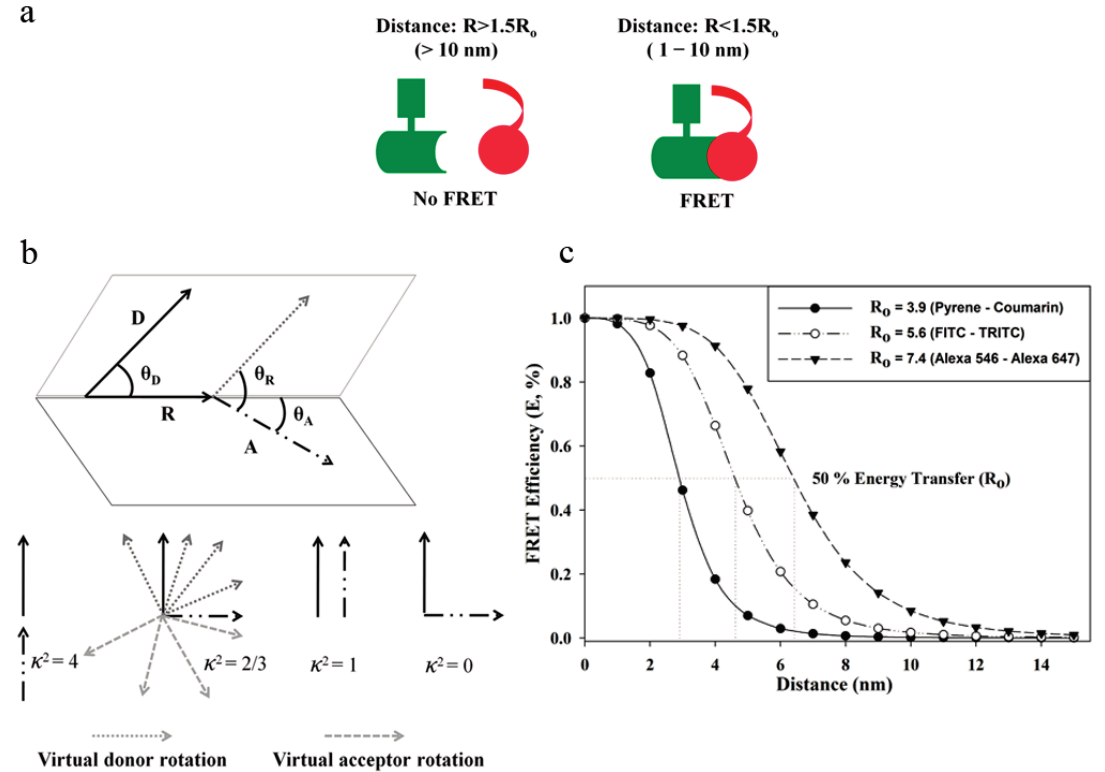
Figure 2. ( a ) A schematic representation of FRET between two molecules; ( b ) The orientation of emission dipole moment of donor and absorption dipole moment of acceptor is illustrated in this figure. “R” is the distance between the centers of donor and